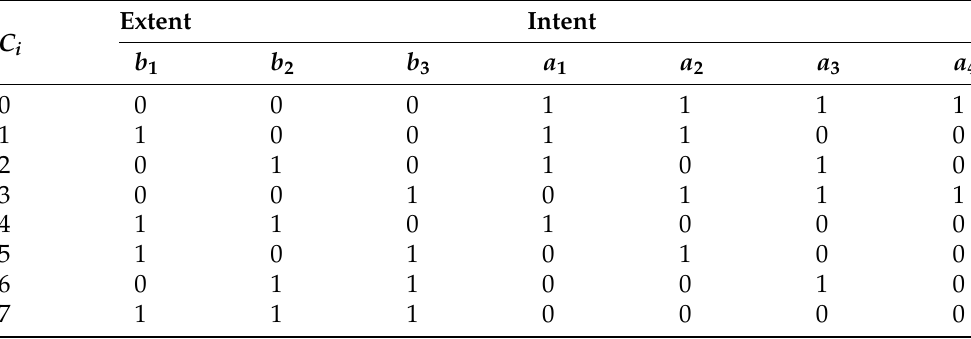
Table 2. List of extents and intents of every concept of the context of Example 1. C